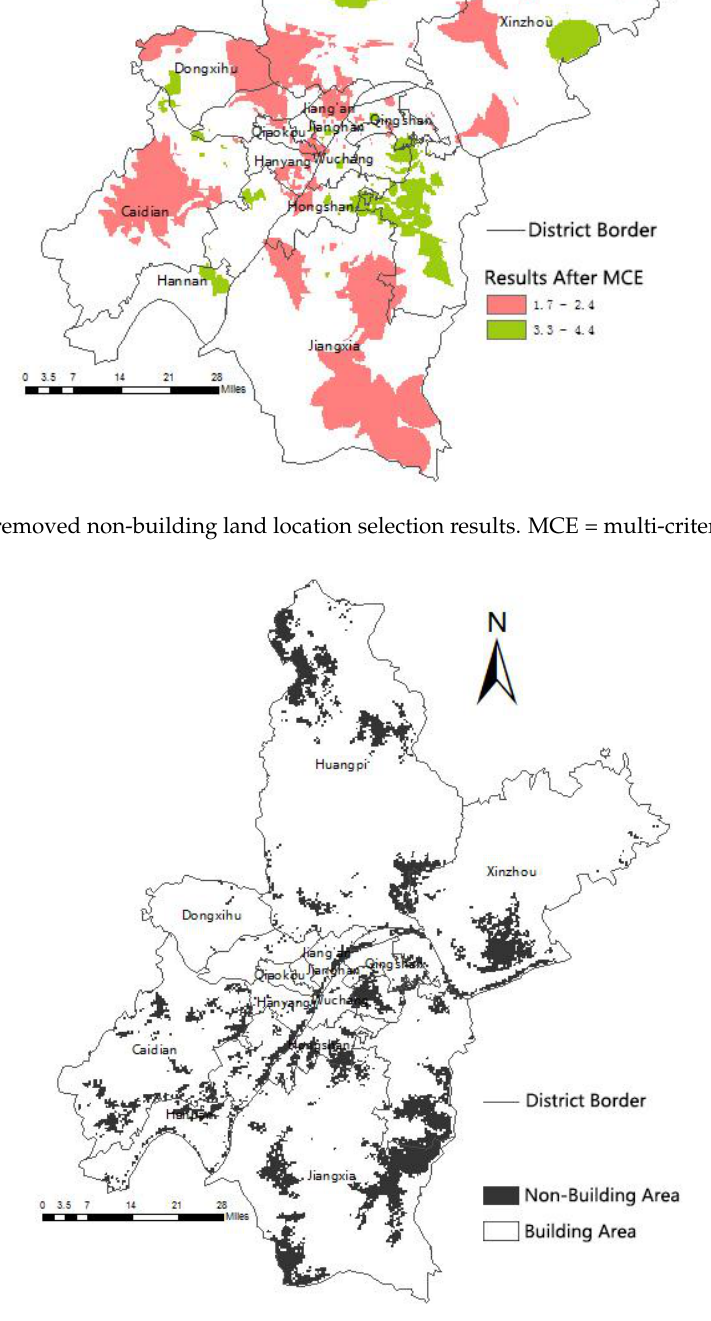
Figure 7. Land use classification map.